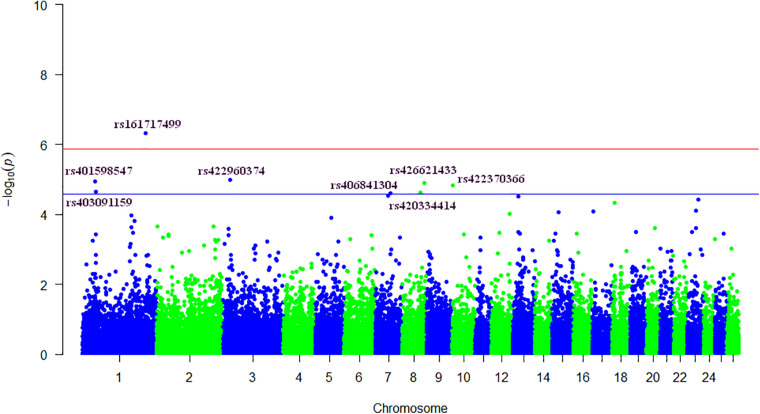
Genome-wide plot of −log10(P-values) for association of SNPs with somatic cell score. Blue and red lines represent suggestive [−log10(P-values) > 4.57] and genome-wide thresholds [−log10(P-values) > 5.87], respectively.